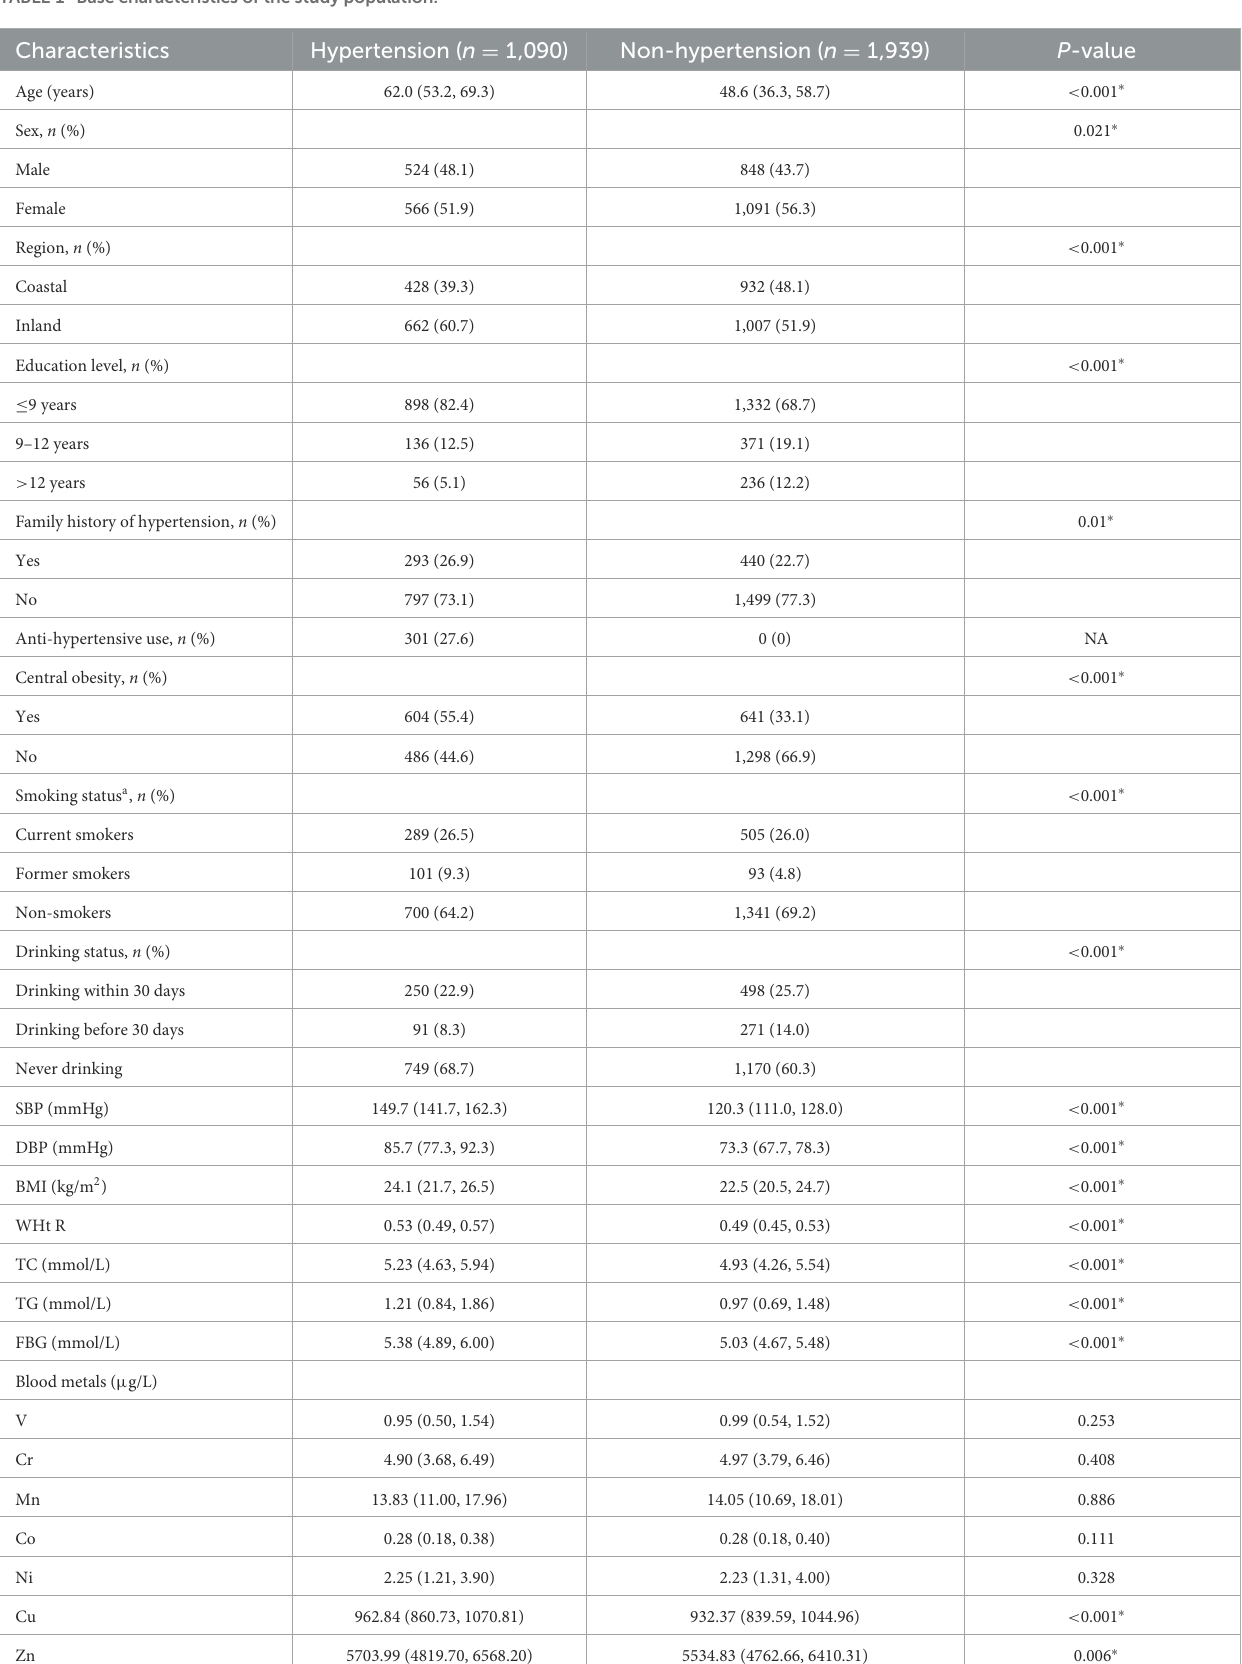
TABLE 1 Base characteristics of the study